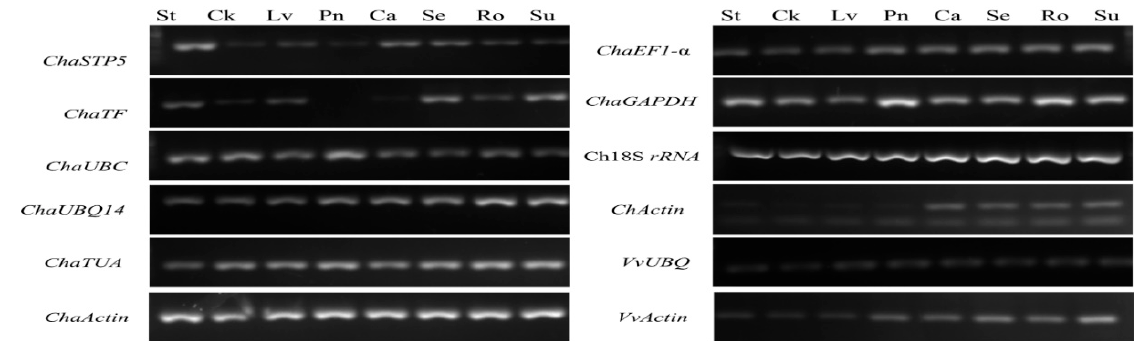
Figure 1. Agarose electrophoresis of 12 candidate reference gene RT-PCR products amplified from different samples. St, blooming styles; Ck, catkins before elongation; Lv, young leaves; Pn, pollen; Ca, cambium of annual branch; Se, green stem; Ro, root tip; Su, sucker.